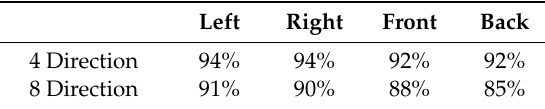
Table 6. Compared our system with the localization algorithm based on the microphone array.